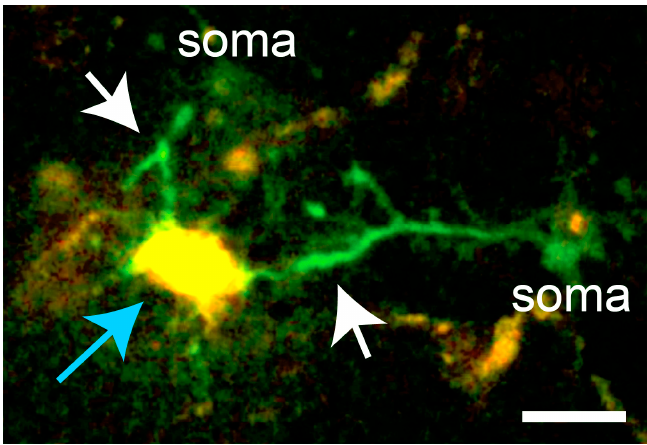
Figure 3. In microglia responding to laser damage (blue arrow), Ca 2+ transients occur predominantly in the processes extending towards the lesion (white arrows). Scale bar, 10 µm. In vivo imaging data from [16].